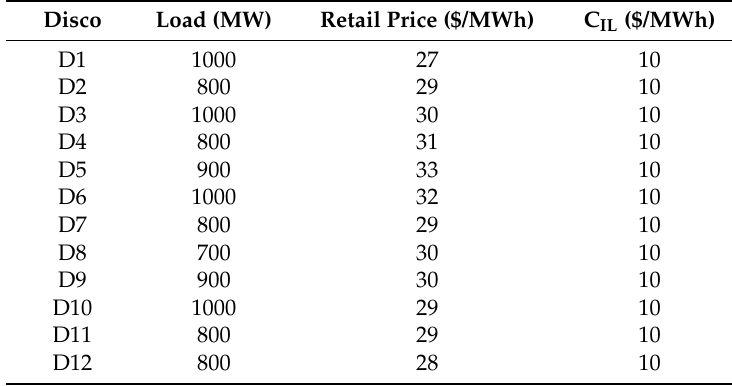
Table A2. Demand side data in an 18-bus network.